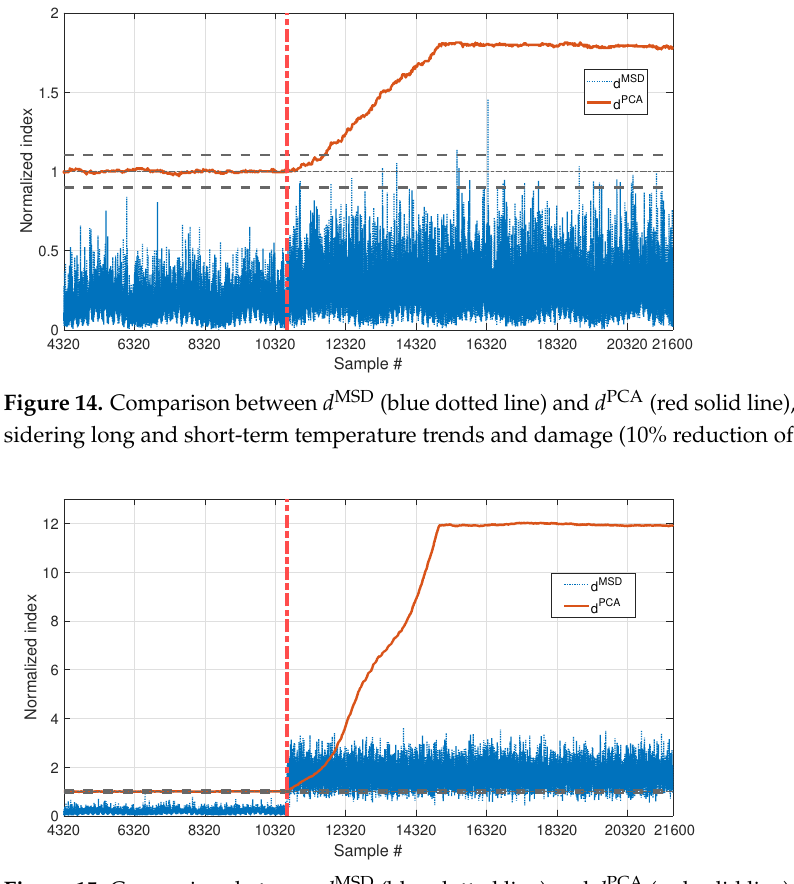
Figure 15. Comparison between d MSD (blue dotted line) and d PCA (red solid line), with b = 4320, con- sidering long and short-term temperature trends and damage (30% reduction of Young’s